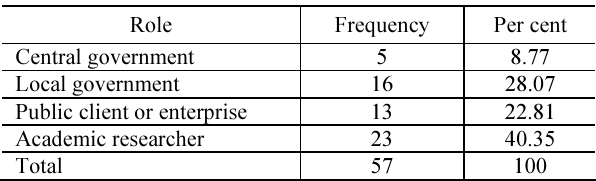
Table 3. Survey Respondents’ Roles in Transportation PPP Projects